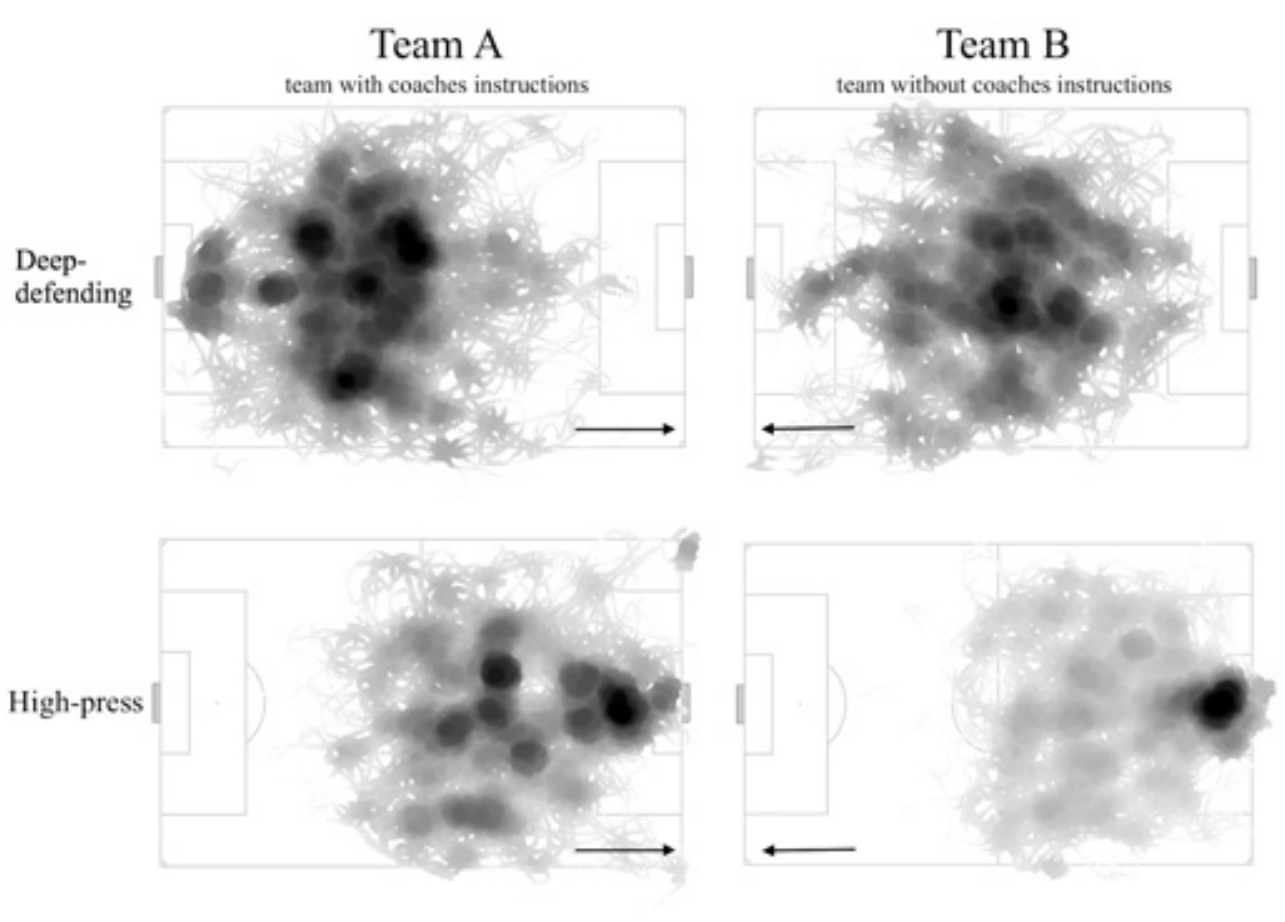
Figure 3. Heat maps of players’ position data when playing in deep-defending and high-press matches. Darker colours represent more time spent in pitch areas. Arrows represent the team’s direction of